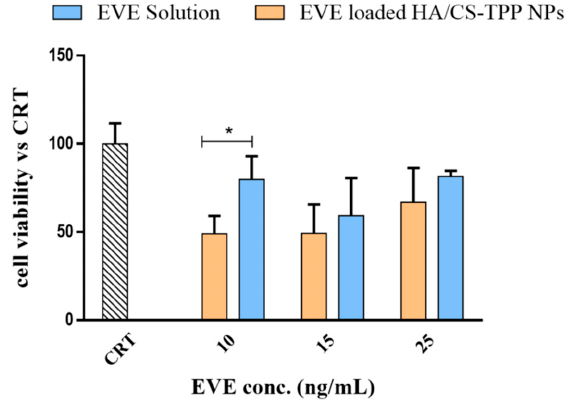
Figure 7. Mesenchymal cells’ (MSc) viability after 4 h of incubation with the EVE loaded HA/CS-TPP NPs and relative EVE solutions (untreated cells are indicated as CRT, striped bar). The